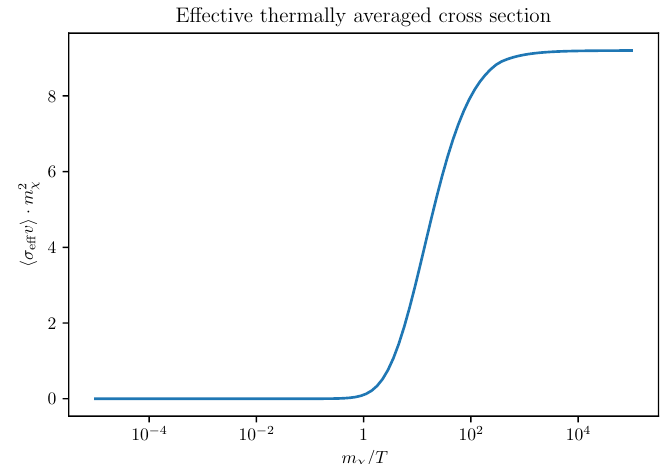
Figure 8. The e(cid:11)ective thermally averaged cross section for a mediator mass m all couplings set to unity. Observe how the cross section approaches a constant value for T